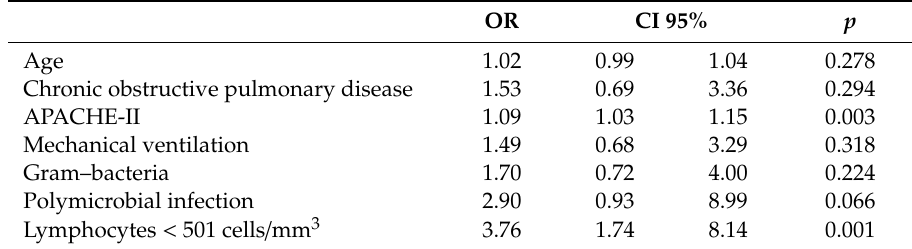
Table 4. Logistic regression analysis for predicting ICU mortality in the sCAP group with no septic shock: lymphocyte count.